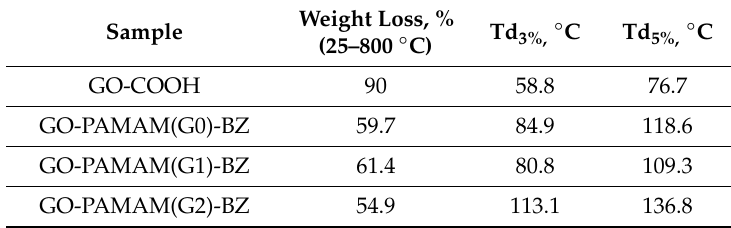
Figure 11. TGA curves for GO-COOH and final benzoxazine functionalized products. Table 4. The TGA data for GO-COOH and final products.